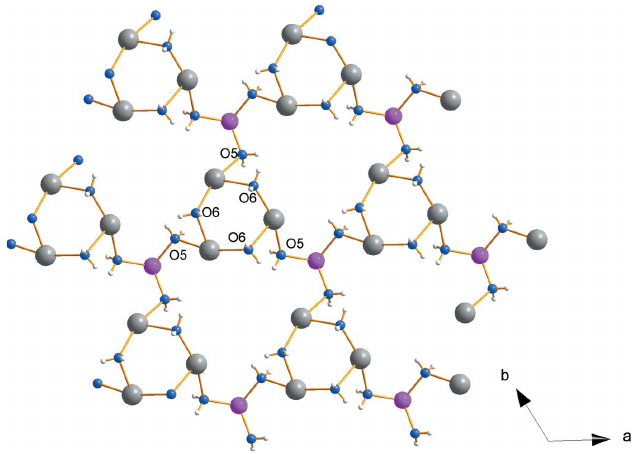
Figure 5 Cation–water coordination network within the ab plane. Sodium = gray, oxygen = blue, lithium = pink, hydrogen = white.